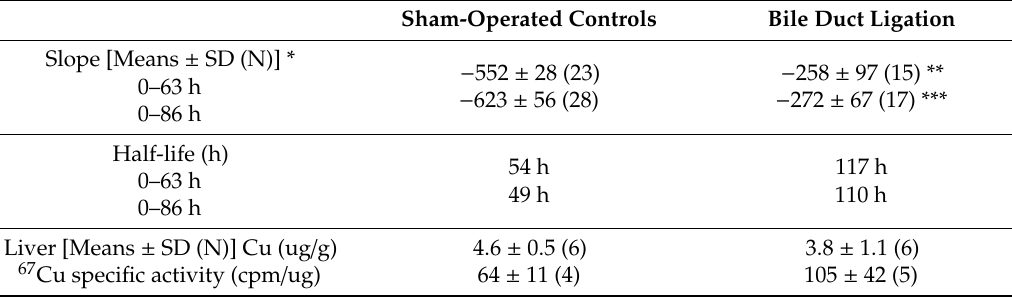
Table 3. Tabulated data on rates of 67 Cu loss in rats where the common bile duct was and was not (sham) ligated prior to 67 Cu administration. Reprinted with permission from Linder, M.C. et al.